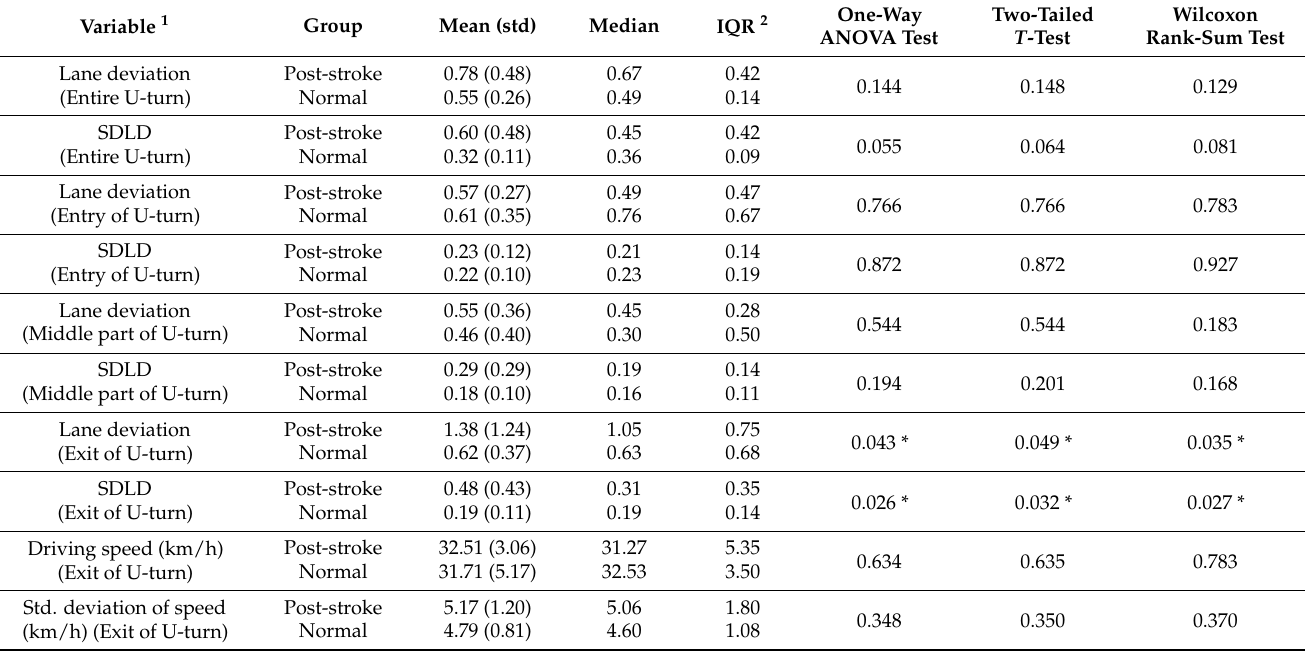
Table 2. Statistical tests of lane keeping performance and speed control in